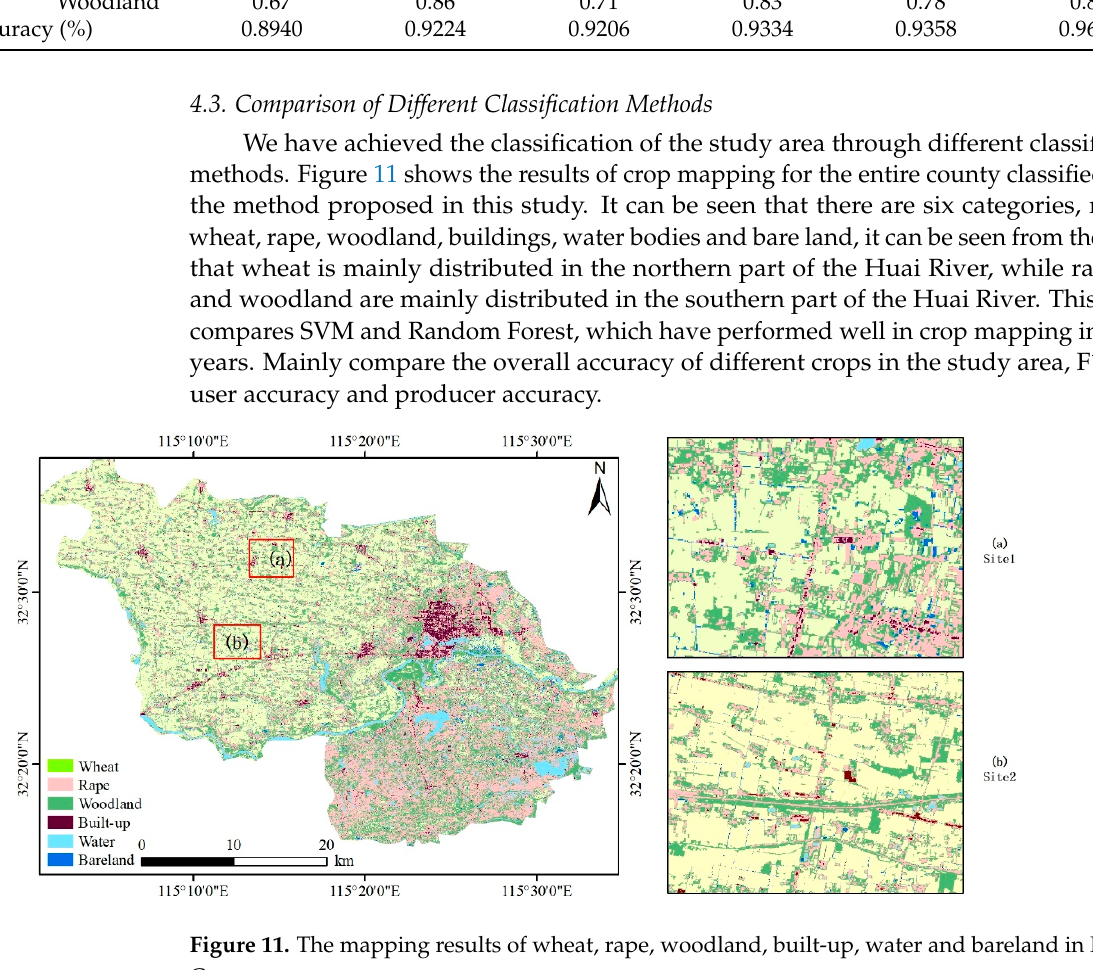
Figure 12. The crop mapping results and overlay analysis based on different methods. Site 1 and site2 are selected from Huaibin County. ( a ) Comparison of improved GWO-SVM mapping results, ( b ) comparison of RF mapping results, ( c ) comparison of SVM mapping results. Table 6. The classification accuracy for improved GWO-SVM, RF and SVM. Classification